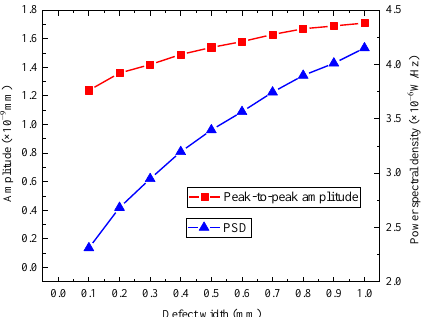
Figure 31. The influence of defect width on the received signal (reflected wave).